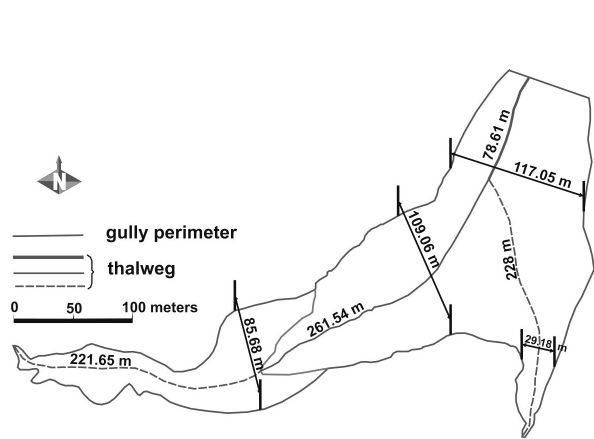
Fig. 8. Morphometry of the Cucuteni-Baiceni gullies in 2010